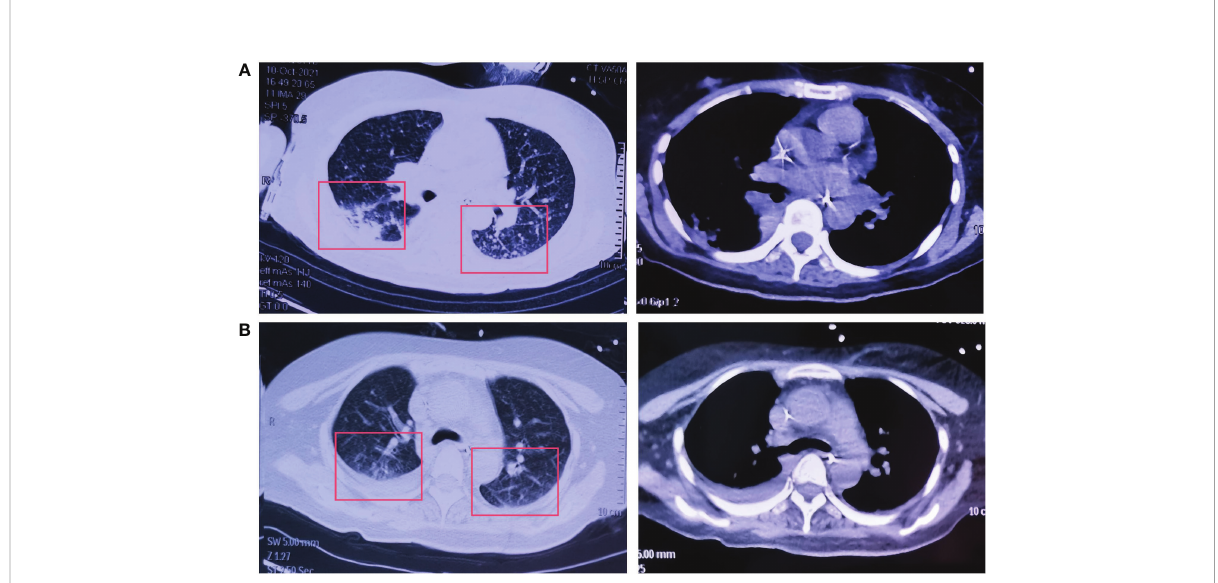
FIGURE 3 The CT of the chest after lazertinib and amivantamab treatment. (A) Increased size and number of diffuse nodules in both lungs on chest CT after amivantamab alone on October 9, 2021; (B) Decreased size and number of diffuse nodules in both lungs on chest CT after lazertinib in combination with amivantamab on December 30, 2021.